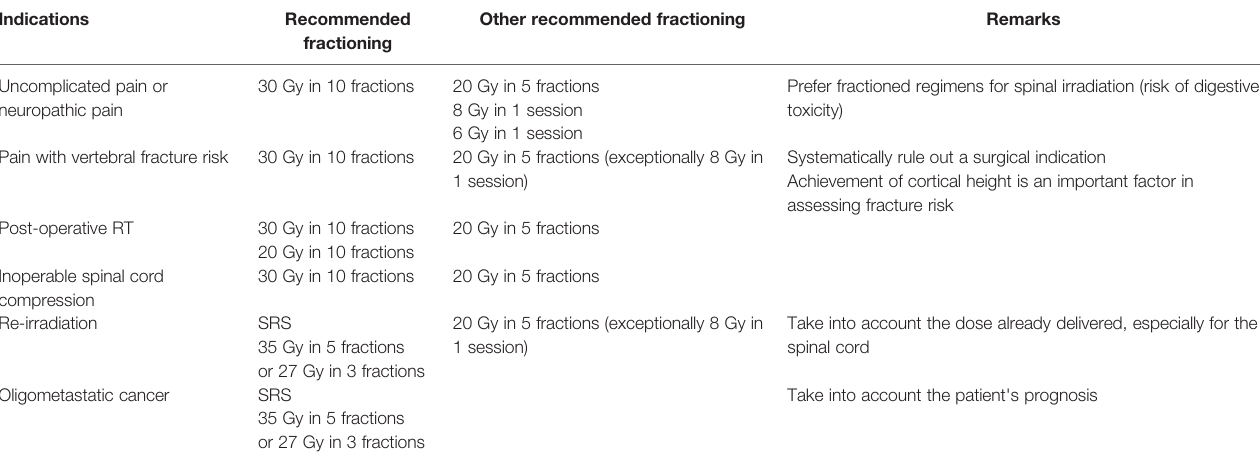
TABLE 3 | Irradiation fractions of vertebral metastases [based on Thureau et al. (73) a French review concerning fractionations in radiotherapy of bone metastases]. Indications Recommended